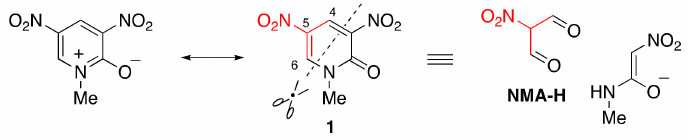
Figure 1. Resonance structure of dinitropyridone 1 and its partial